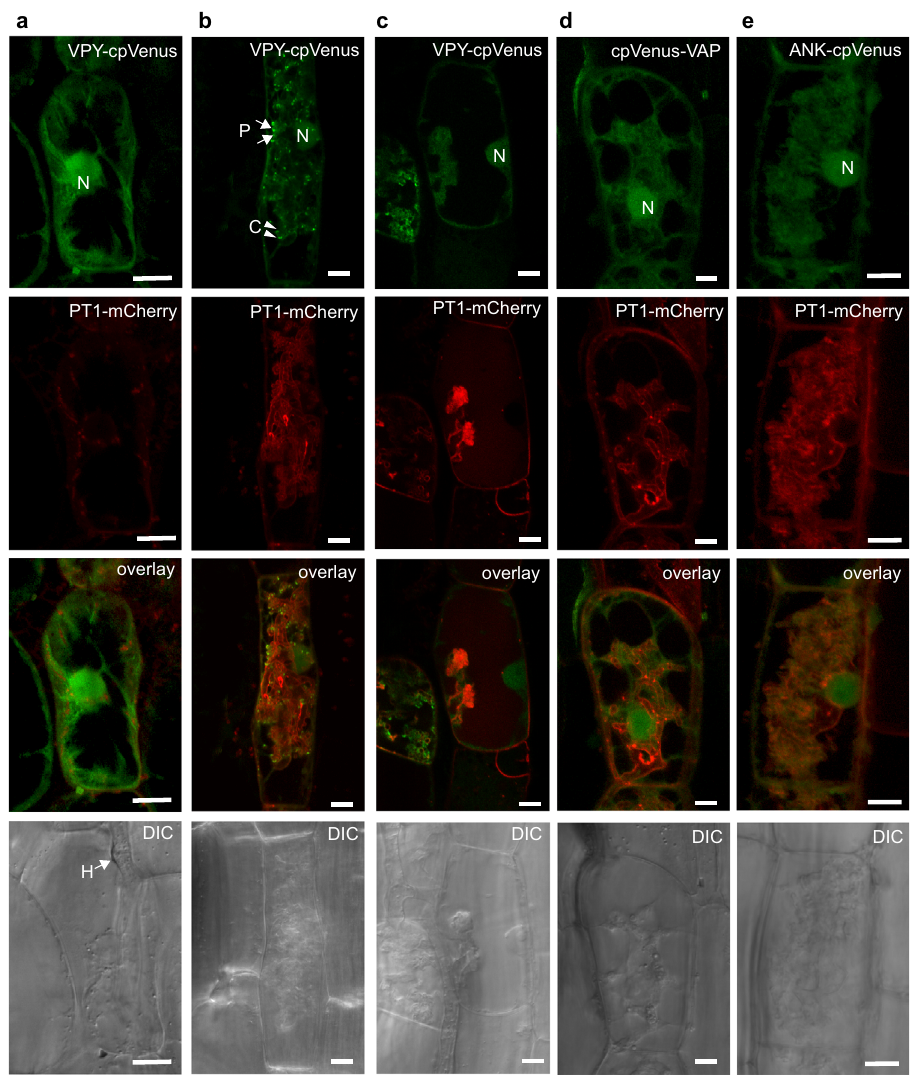
Fig. 1 | Subcellular localization of full-length VPY, VAP/MSP, and ankyrin repeat (ANK) domains. Medicago truncatula roots expressing either VPY pro :VPY- cpVenus ( a – c ) , VPY pro :cpVenus-VAP ( d ) or VPY pro :ANK-cpVenus ( e ) (green) and plasma membrane (PM) and periarbuscular membrane (PAM) marker BCP1 pro :PT1- mCherry (red)colonizedwith Rhizophagusirregularis .Imagesofindividualcortical cells prior to and during arbuscule development reveal the subcellular location of VPY ( a ) before AM fungal entry, ( b ) formation of fi ne branches, ( c ) fully collapsed